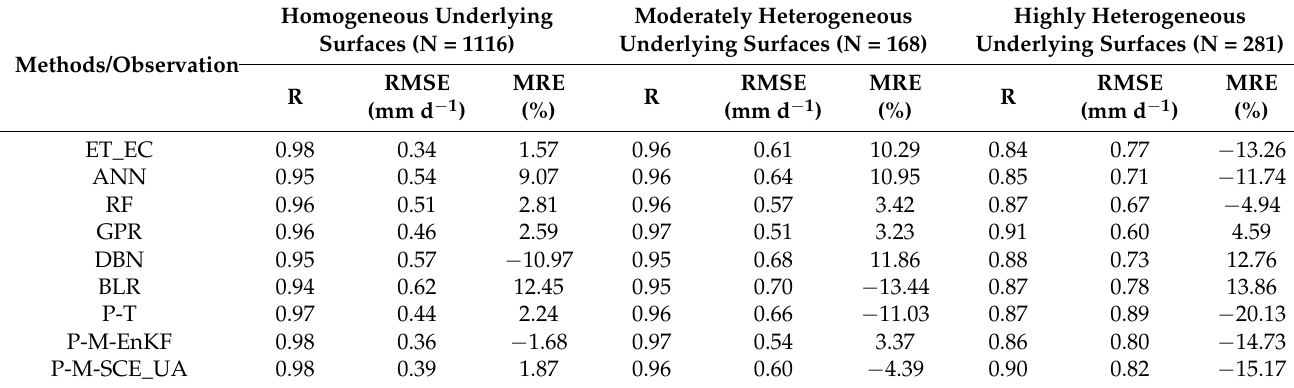
Table 2. Statistics for comparison among the upscaled ET of eight upscaling methods, ET_EC, and LAS measurements.